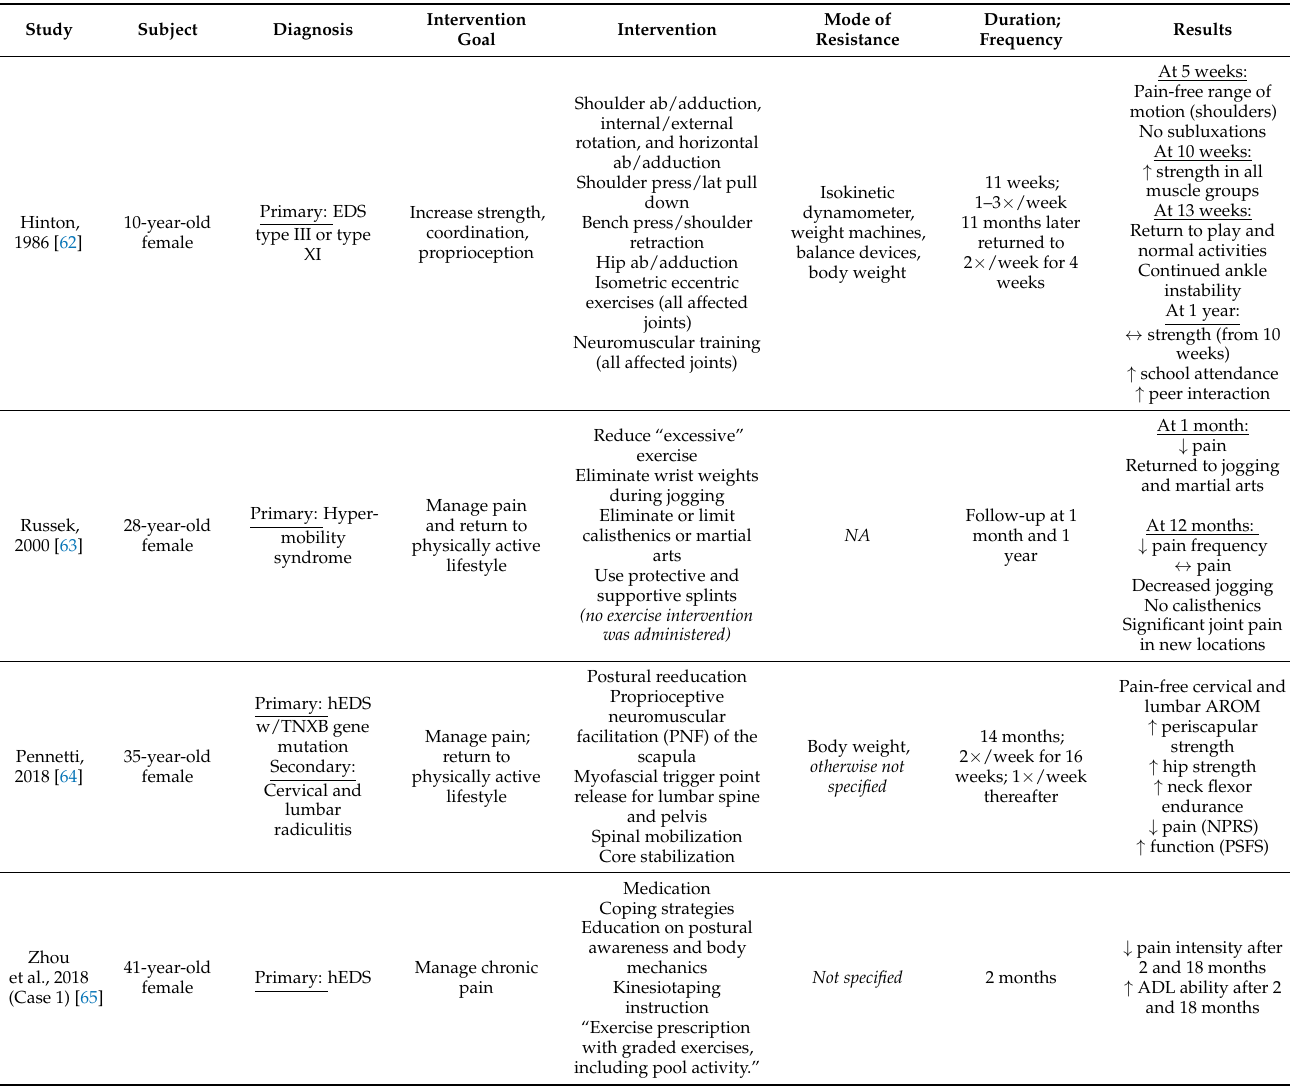
Table 1. Outcomes of Case Studies including Exercise Advice or